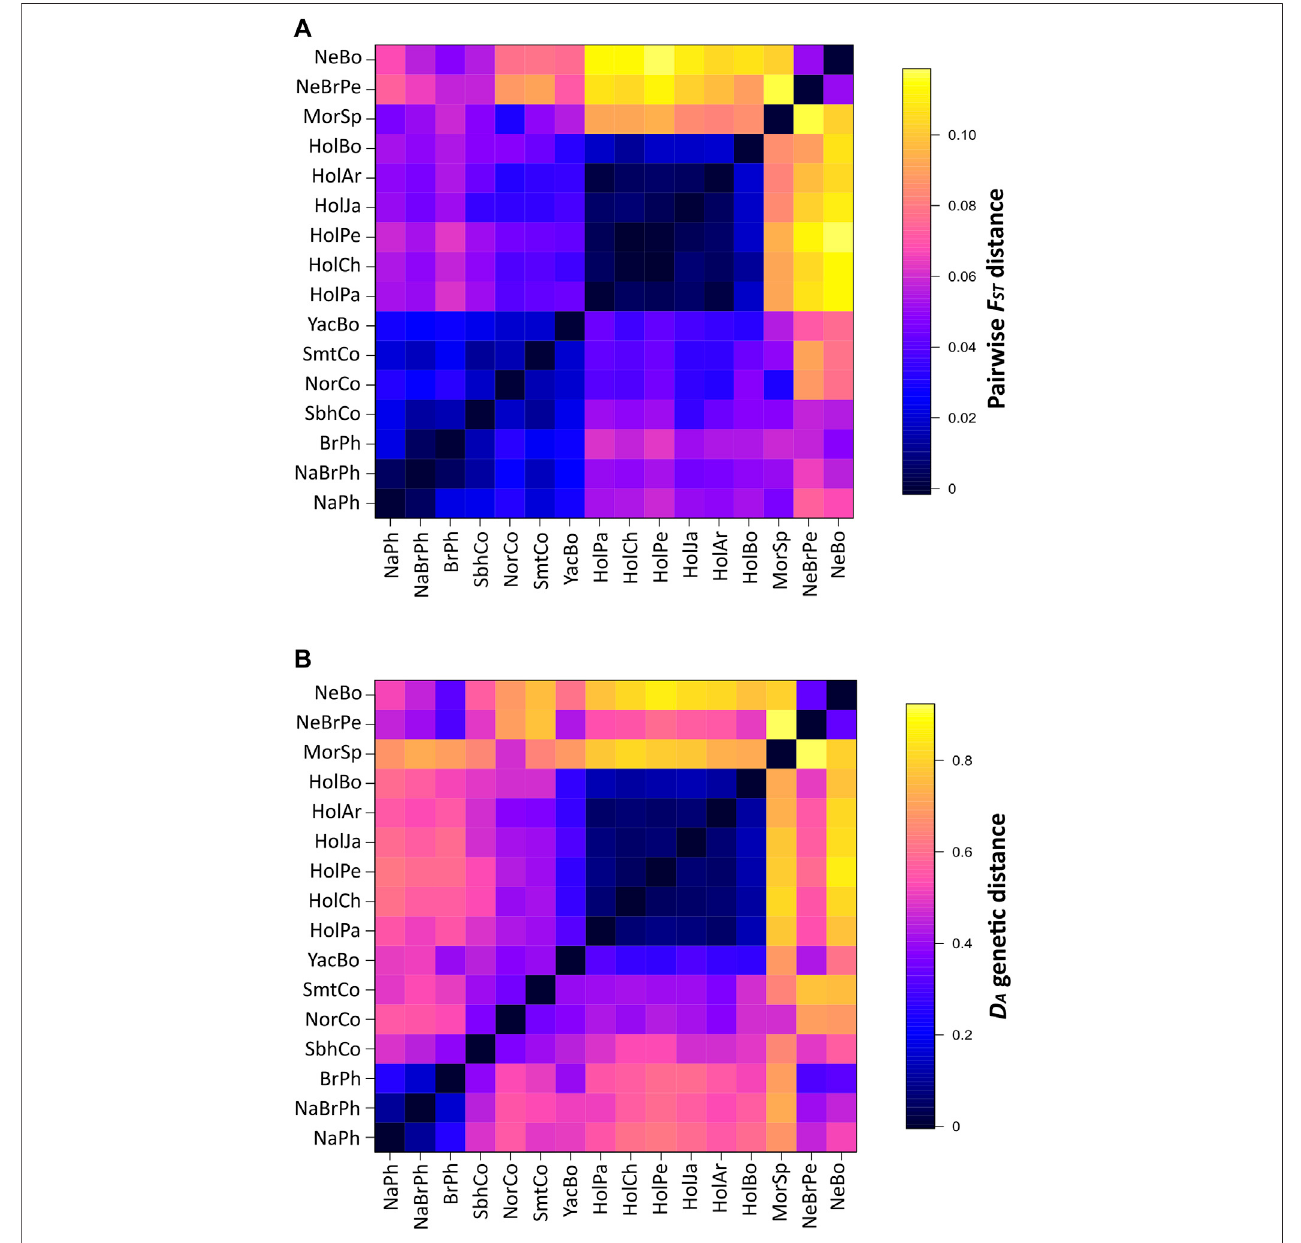
FIGURE 1 | Pairwise F ST and D A genetic distances between populations. Symmetrical heat maps for pairwise F ST values (A) and D A genetic distance (B) between cattlepopulationsbasedon BoLA-DRB3 alleles.Allpairwise F ST comparisons(exceptforChileanwithPeruvianHolsteinandArgentinianwithParaguayanHolstein)were signi fi cant at 0.05